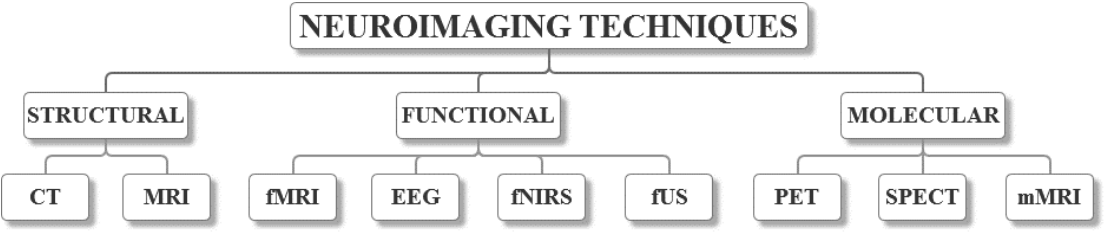
Figure 1. The classification of commonly applied neuroimaging techniques.